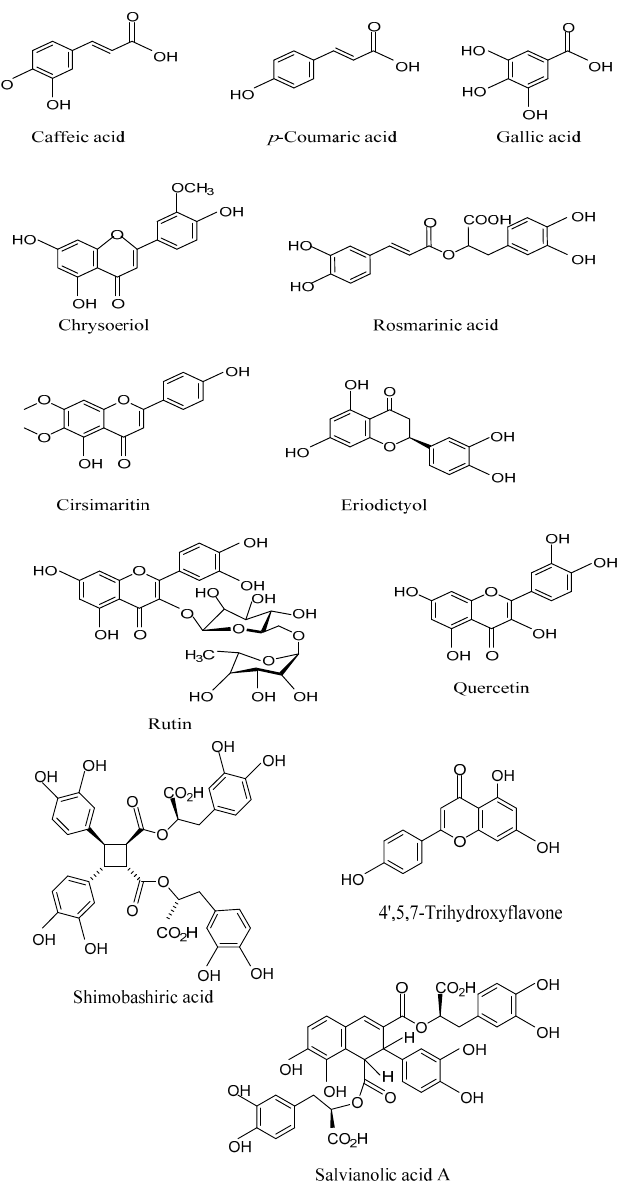
Figure 2. The structures of some of the non-volatile chemical constituents.